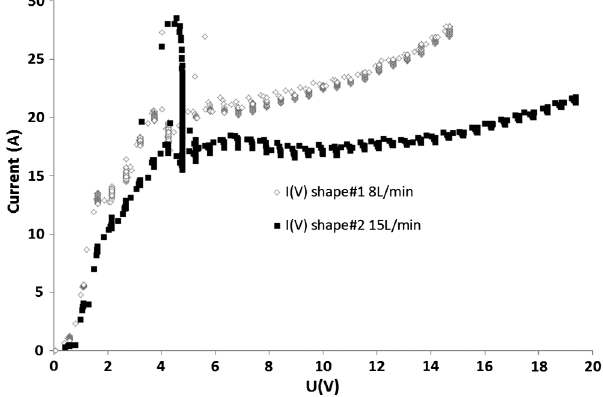
FIG. 8. I ð V Þ curves plotted on single-cell cavity with cathode shape #1 & #2.